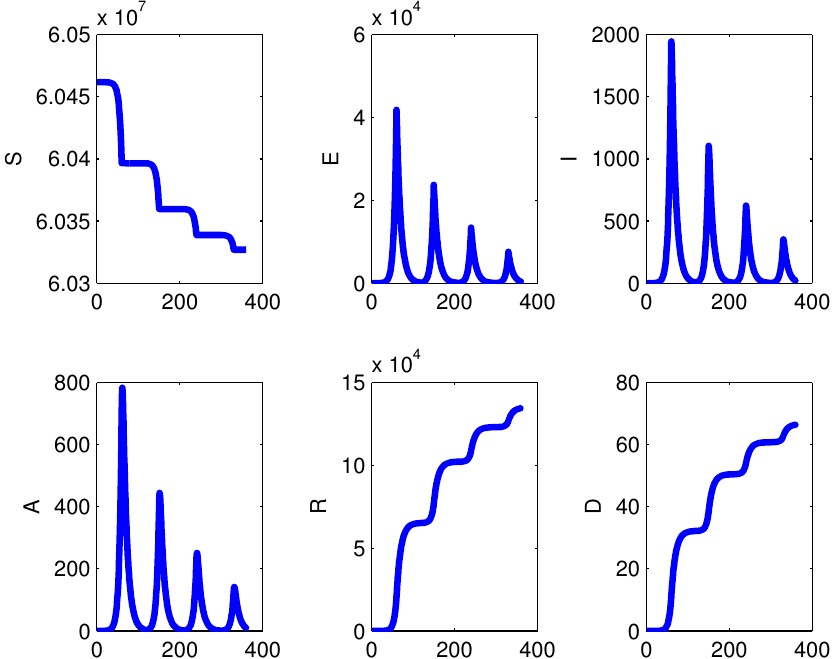
Figure 22. The population values with the lock-down policy, implemented after the first month with the reduced contact rate β I = 10 − 10 , after which β I = 10 − 7 resumes. The check for possible repeated implementation is implemented every month afterwards. The simulation runs over a two years timespan for the model (1) with no demographics, i.e., Λ = d p = 0. Left to right and top to bottom, the subpopulations are: S , E , I , A , R and D , the disease-related deceased